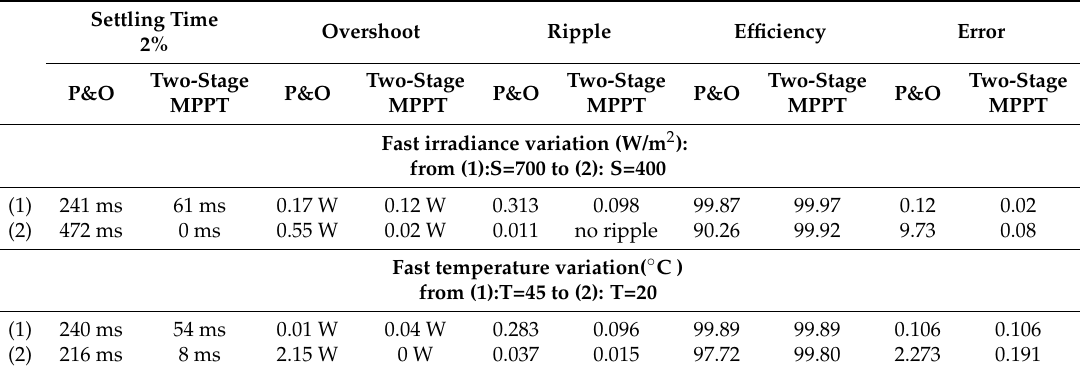
Table 5. Performances of